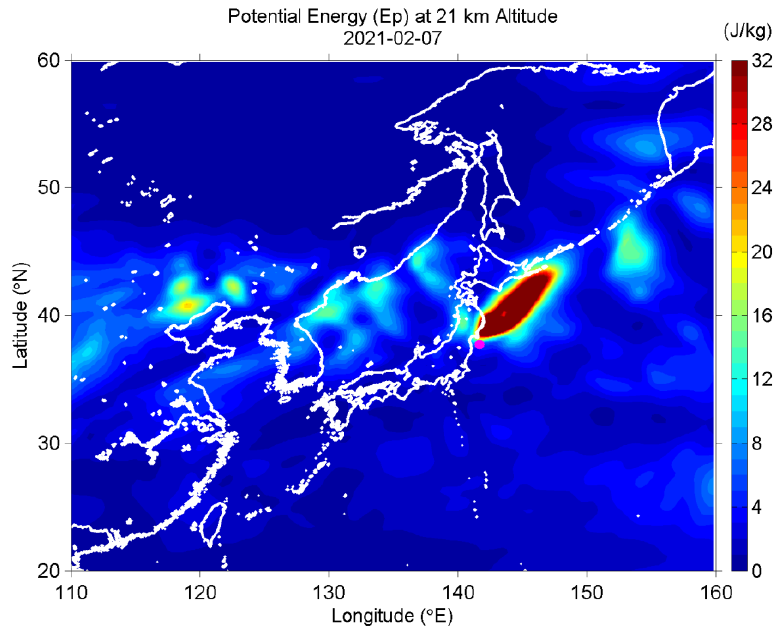
Figure 9. Spatial distribution of Ep at a specific altitude of 21 km on 7 February 2021. The magenta dot indicates the EQ epicenter of the first February EQ.